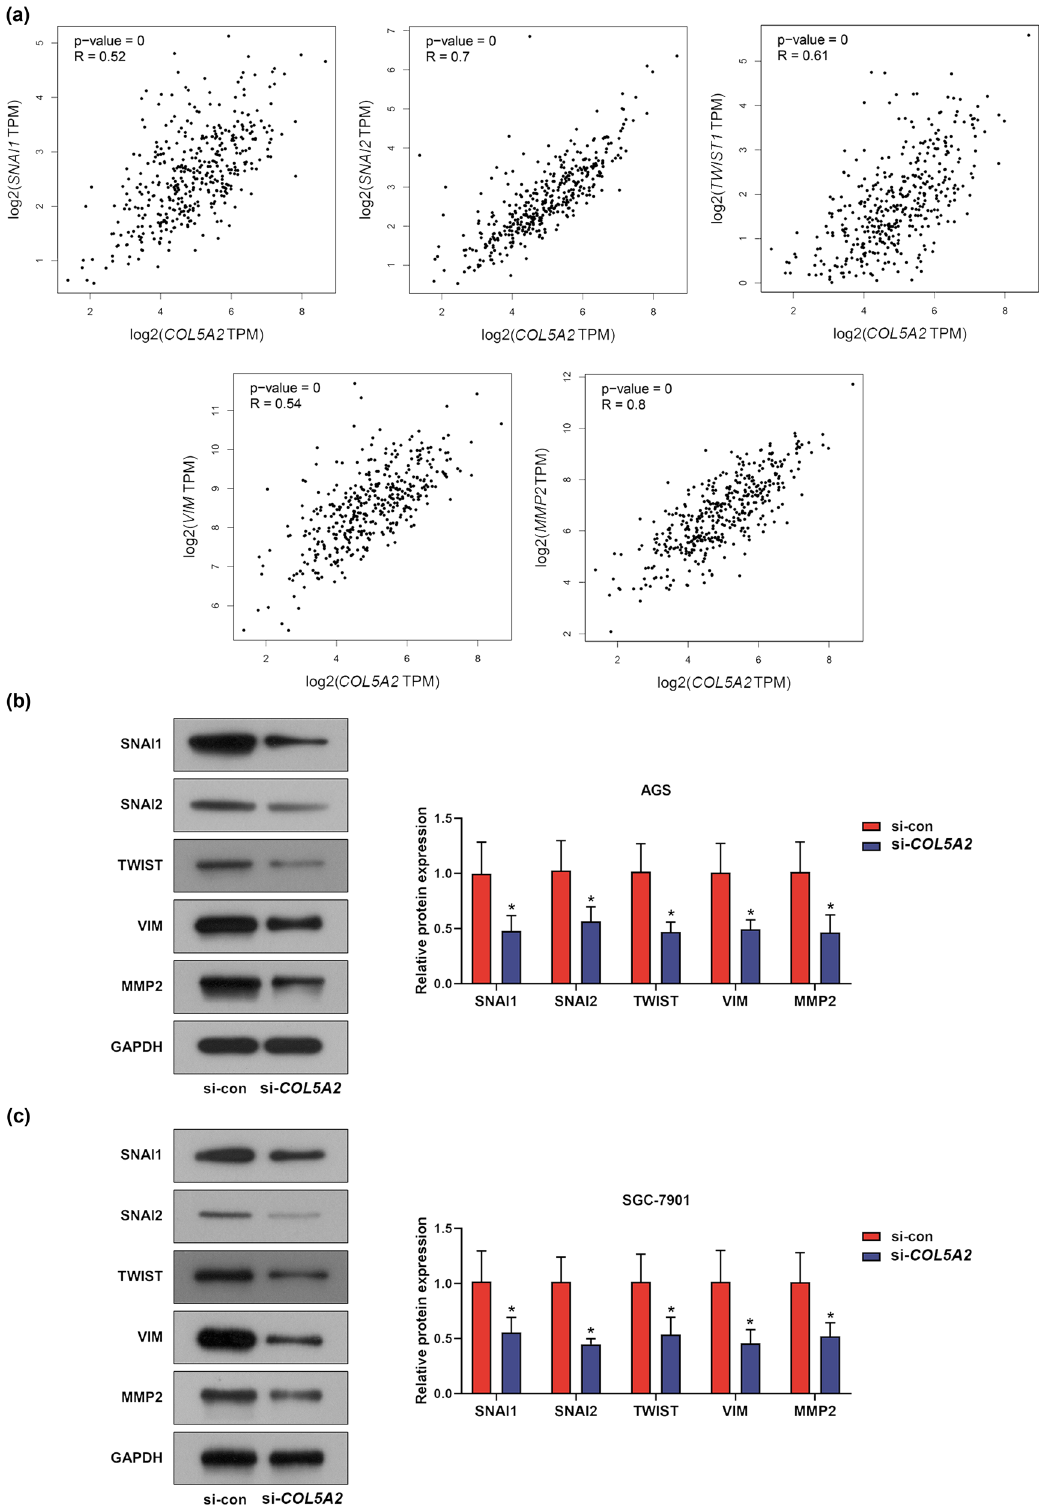
Figure 7: Knockdown of COL5A2 inhibited biological behaviors of GC cells via regulating EMT - associated genes. ( a ) Correlation between COL5A2 expression and EMT - associated genes including VIM , SNAI1 , SNAI2 , VIM , and MMP2 was analyzed with GEPIA. ( b and c ) Protein expressions of VIM, SNAI1, SNAI2, VIM, and MMP2 in si - con - or si - COL5A2 - transfected AGS ( b ) or SGC - 7901 ( c ) cells were determined by western blot assay. Data from three independent experiments were presented as mean ± SD. * P < 0.05 vs si - con